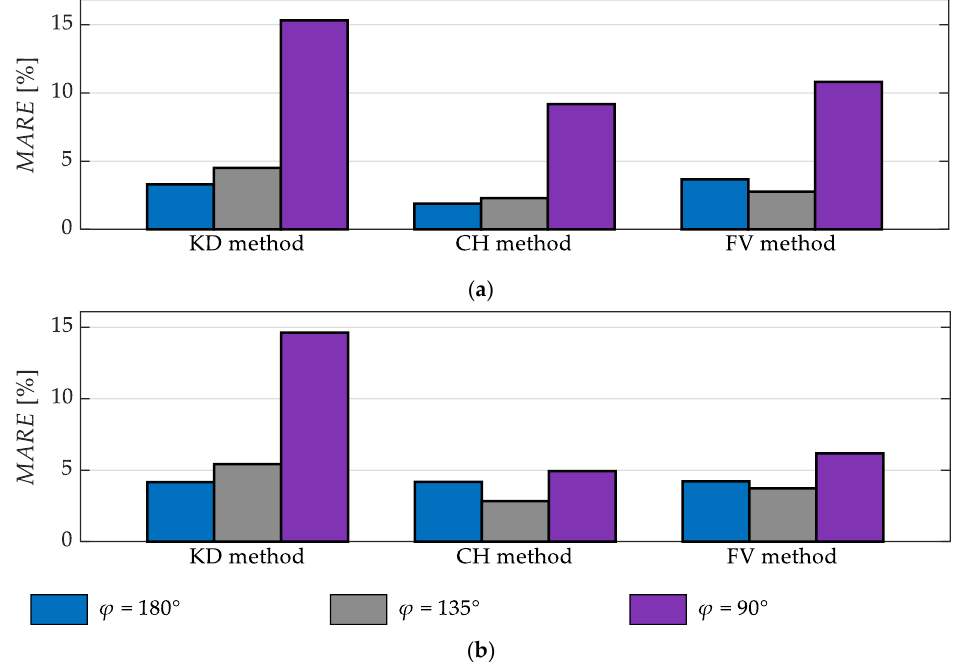
Figure 9. The values of MARE obtained for the step time ( a ) and step length ( b ) for Subjects #1 – #3 for different angles φ between the walking direction and the depth sensor’s line of sight.